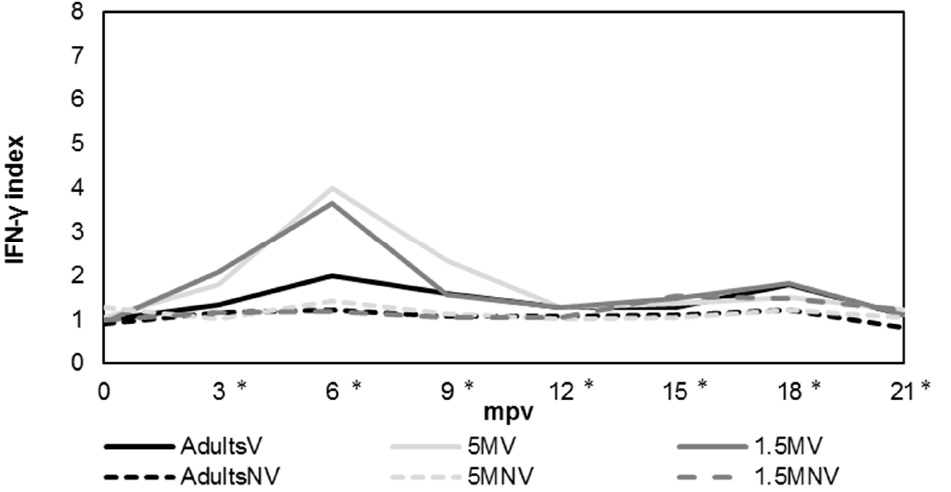
Figure 4. Evolution in the INF ‐γ production after stimulation of blood with bovine PPD according to each experimental group. AdultsV: vaccinated at more than 1.5 years; AdultsNV: not vaccinated at more than 1.5 years; 5 MV: vaccinated at 5 months; 5 MNV: not vaccinated at 5 months; 1.5 MV: vaccinated at 1.5 months; 1.5 MNV: not vaccinated at 1.5 months; mpv: months post vaccination; * significant differences ( p < 0.05) among vaccinated and not vaccinated groups. Results were expressed as a quotient between the mean O.D. of the bovine PPD-stimulated plasma and the mean O.D. of the same plasma incubated with